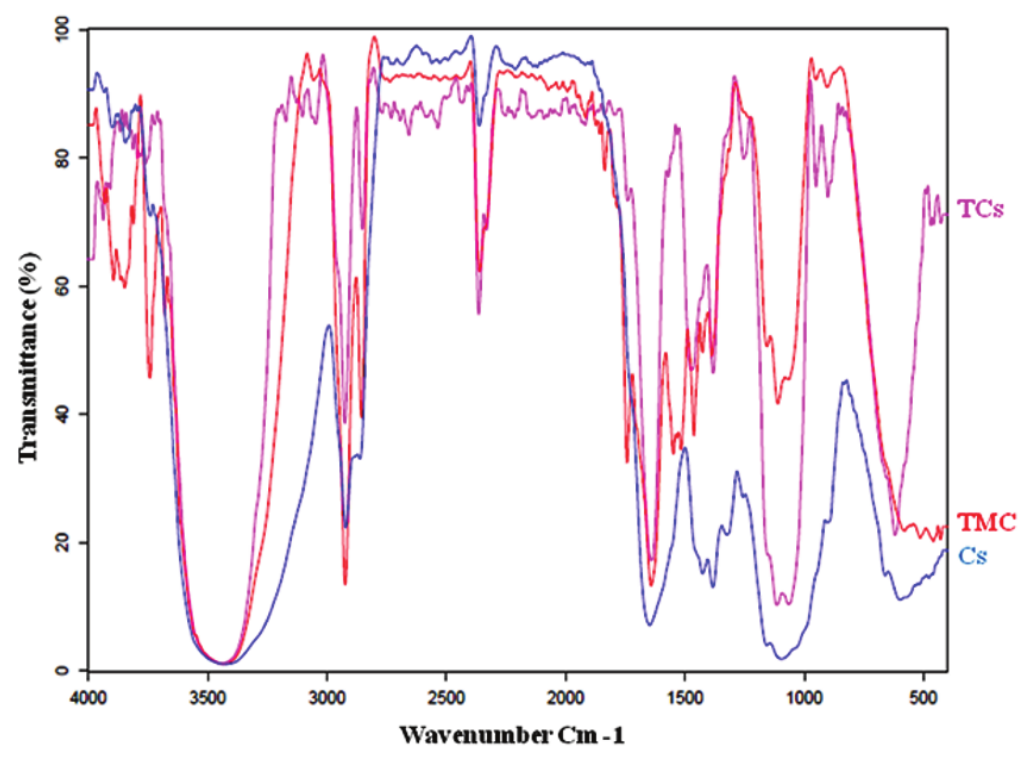
Figure 2. 1 H-NMR spectrum of TMC in